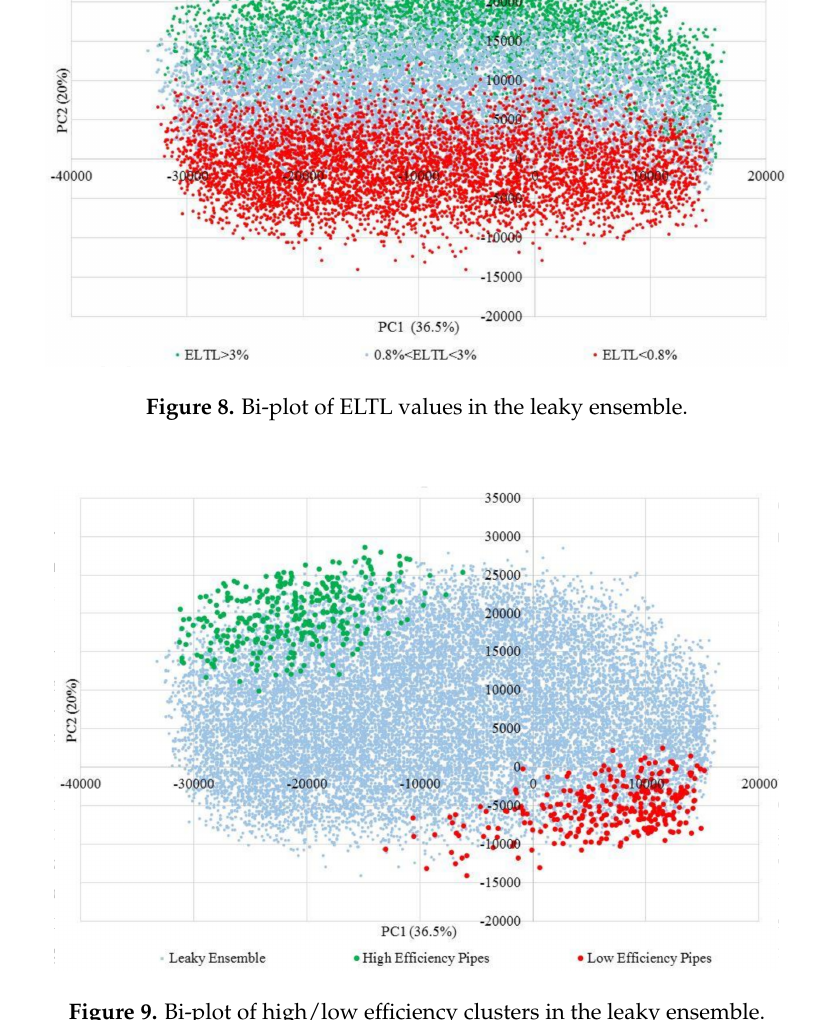
Figure 9. Bi-plot of high/low efficiency clusters in the leaky